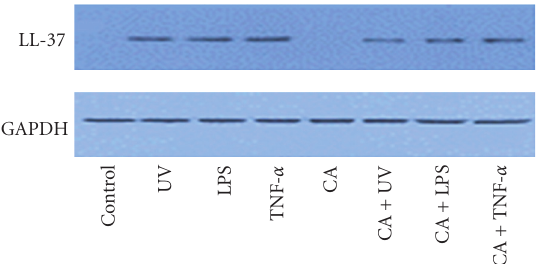
Figure 5: The expression of LL-37 protein in keratinocytes was evaluated by Western blotting using polyclonal antibody to LL-37 at 6, 12, and 24 hours post stimulation. The expression of LL- 37 was downregulated after additional treatment with calcipotriol compared to the stimulated keratinocytes with LPS, TNF- α , and UVB